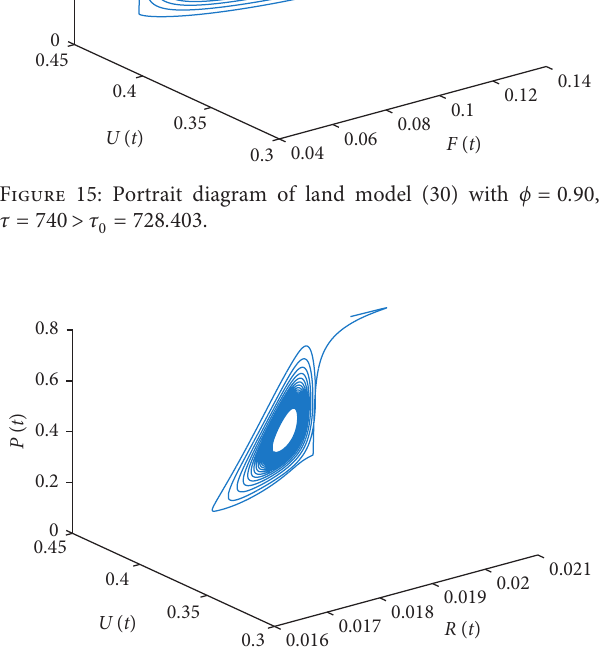
Figure 16: Portrait diagram of land model (30) with ϕ � 0 . 90, � 728 . τ � 740 > τ 0